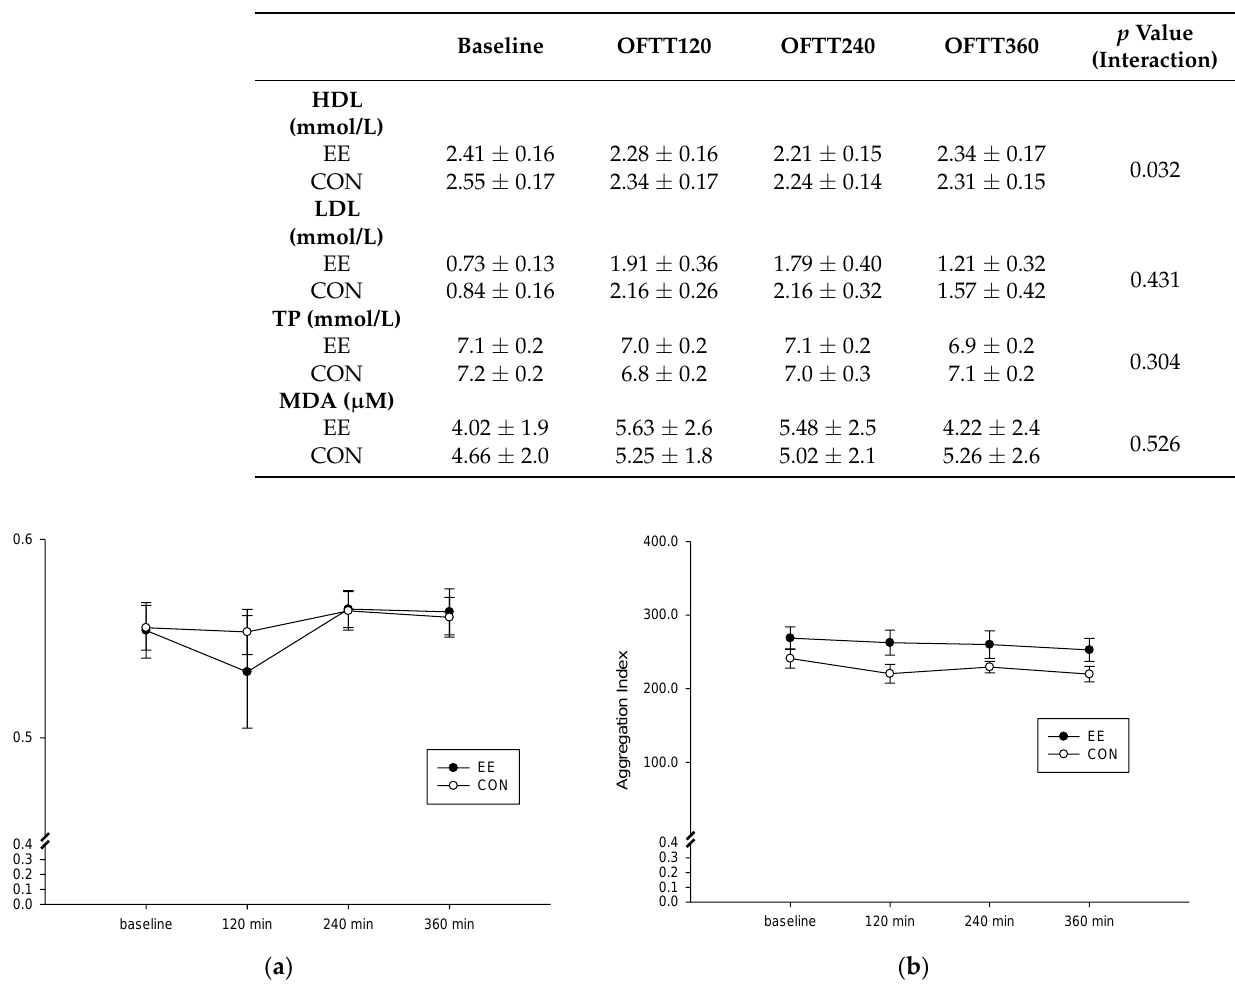
Figure 4. Fasting and postprandial 6 h of red blood cell deformation degree ( a ) and aggregation degree ( b ) on the control (CON) ( ○ ) and endurance exercise (EE) (●) trials. Values are mean ± SD, n = 8.